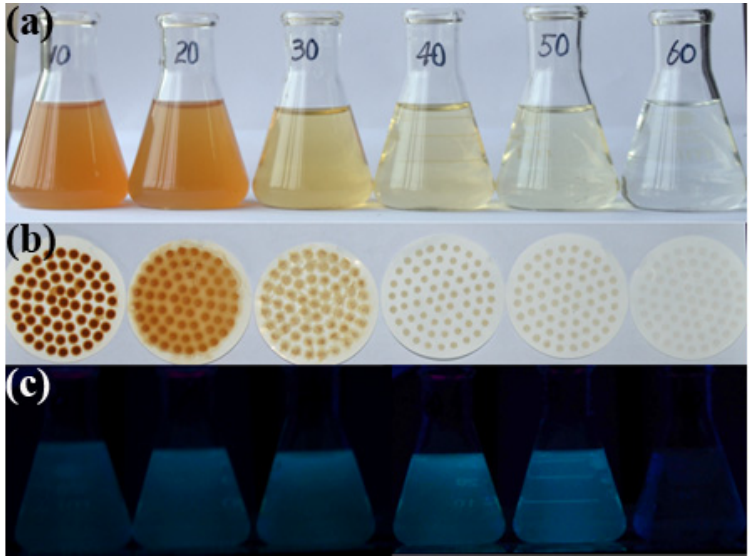
Figure 1. Pyrolysis results for ( a ) the initial product solution; and ( b ) the residual lignin after 10, 20, 30, 40, 50 and 60 min hydrothermal reaction; and ( c ) the corresponding filtrate image under 365 nm UV lamp irradiation.